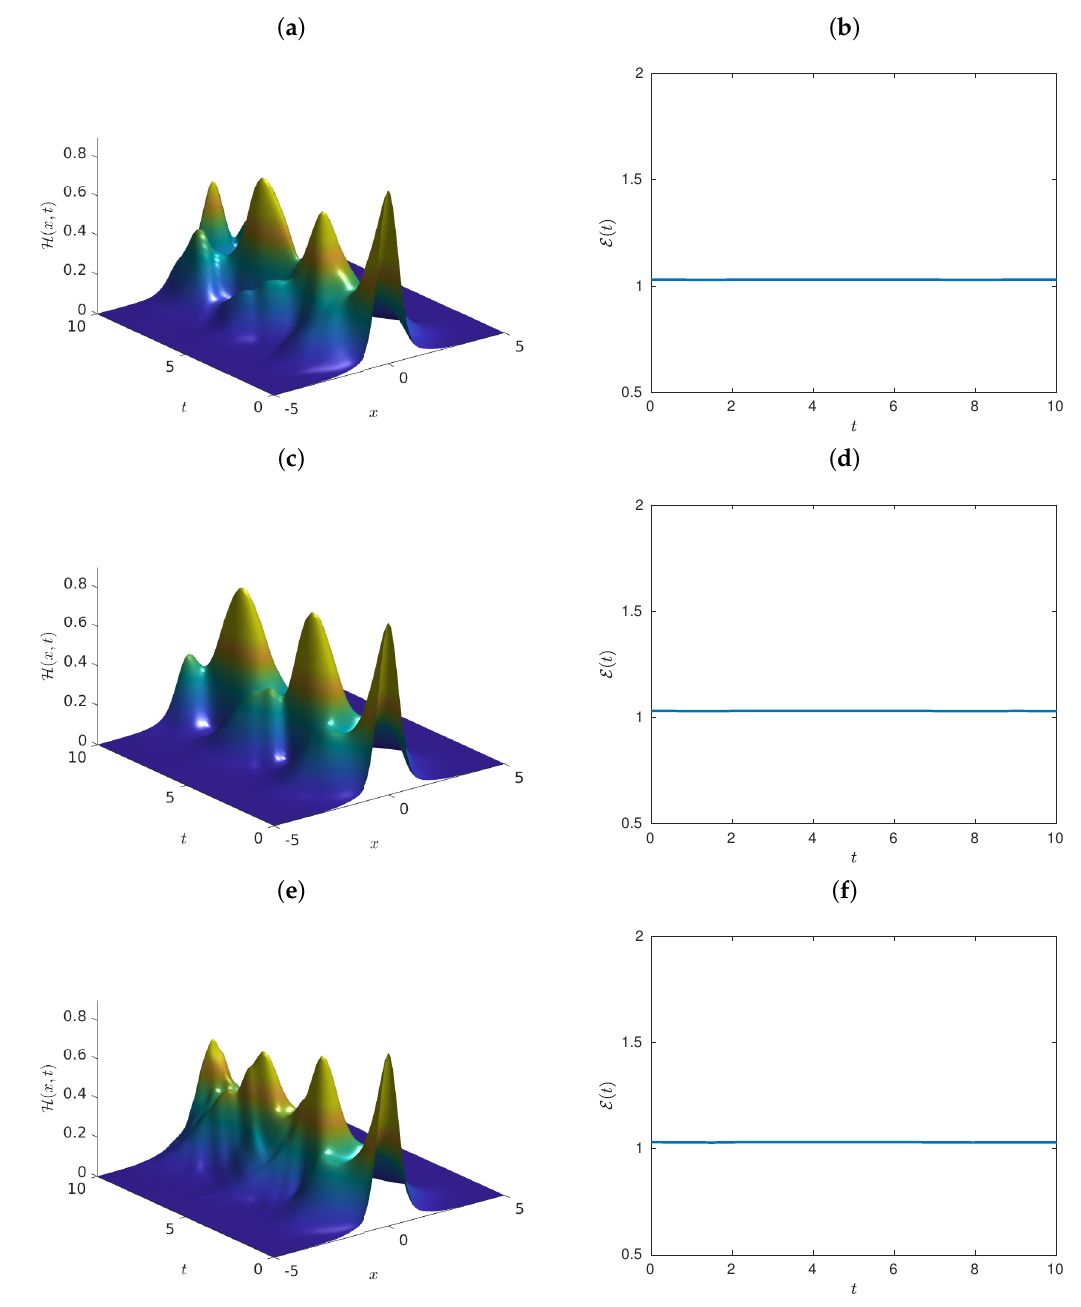
Figure 5. Approximate solutions for the problem (4) using the parameters in Table 1, and the computational time-steps h = 0.1 and τ = 0.05 for the finite-difference method (36). We used V ( x ) = 1 1 √ exp ( − x 2 ) . (left column) Approximate graphs of the discrete energy density H versus ( x , t ) . (right column) Graphs of π the total energy E versus t . We used α 1 = 1.1 and α 2 = 1.9 ( a , b ), α 1 = 1.5 and α 2 = 1.5 ( c , d ), and α 1 = 1.9 and α 2 = 1.1 ( e , f